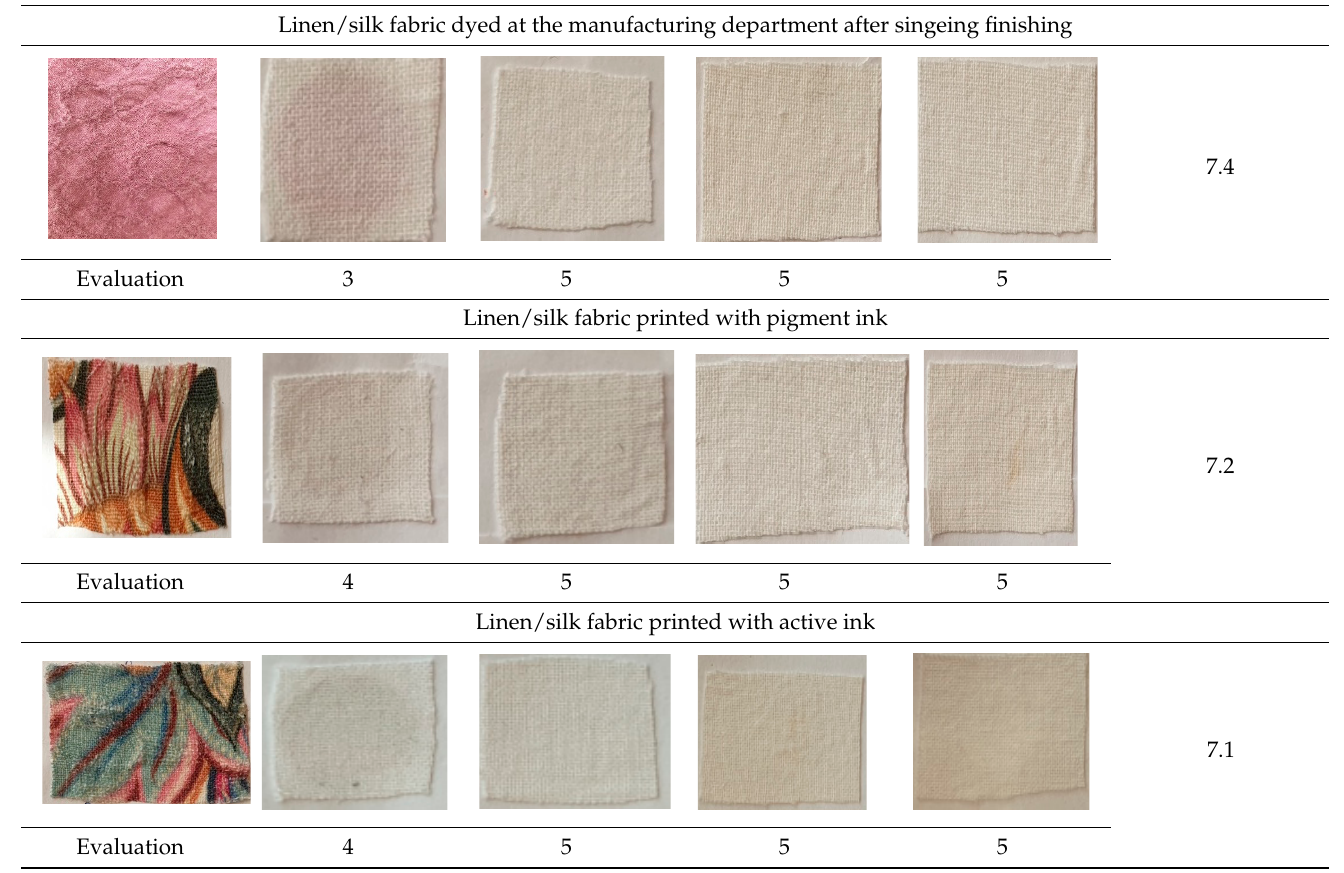
Table 2. Results and evaluations of the fastness of the researched linen/silk fabric.